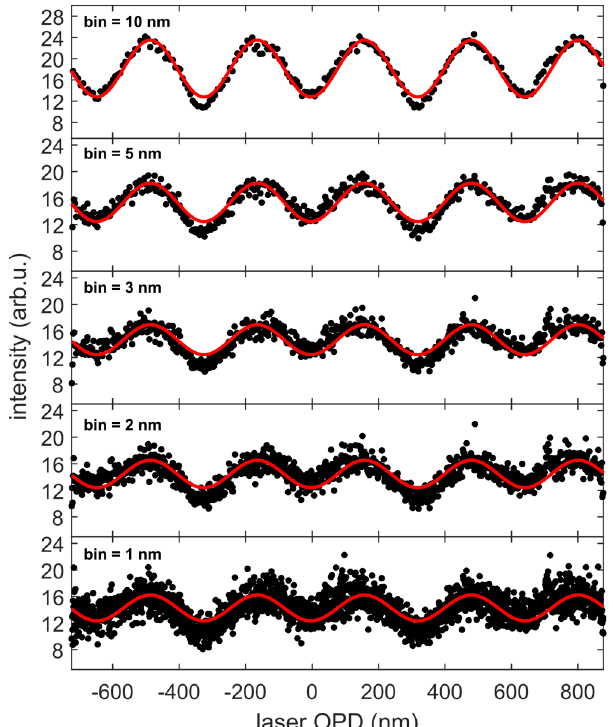
Figure 7. Standard deviation of the laser intensity data from the fit plotted as a function of optical path difference s . The black scatter represents the data, and the red curves are fits of a form sin2 2 π λ L is the laser wavelength. Each data point is the center of a bin, the size of which is indicated in the left top corner of each plot.